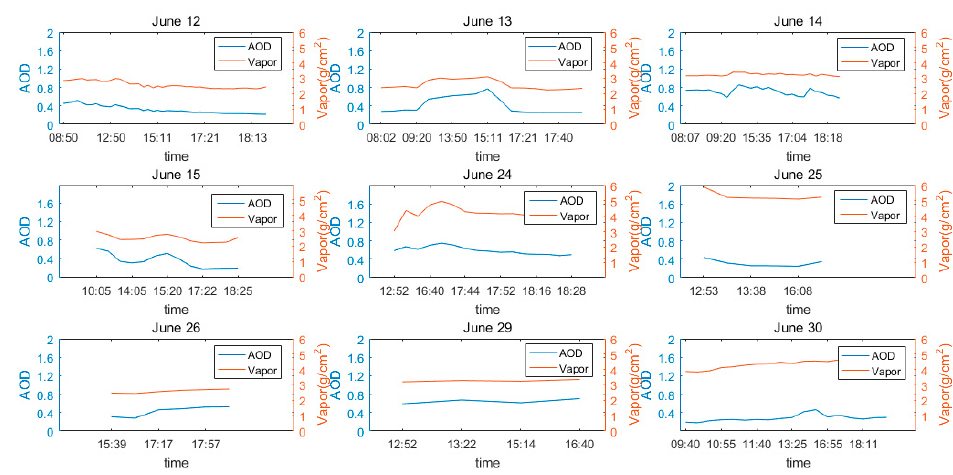
Figure 4. Sequential variations in AOD and water content, based on sun photometer data.